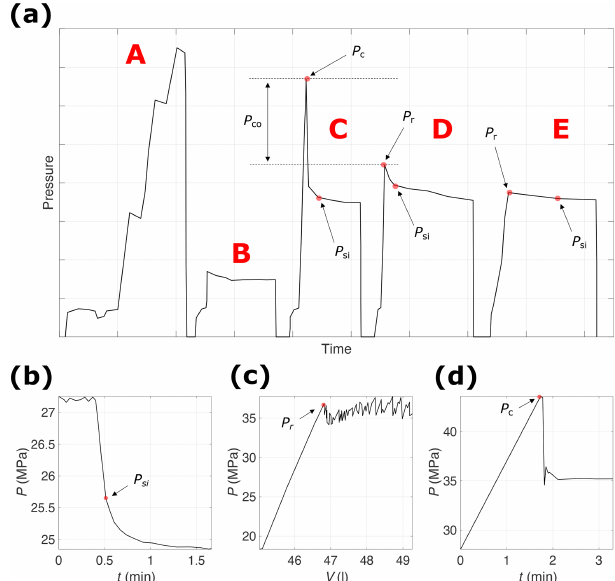
Figure 4. (a) A schematic example of a hydrofracturing test carried out in a coal mine within the Ruhr region (A – packer inflation, B – pressure pulse test, C – fracture initiation test, D – first refracturing test, and E – second refracturing test, P c – breakdown pressure at fracture initiation, P r – fracture reopening pressure, P si – shut-in pressure during fracture closure, P co – rock mass (hydrofracturing) tensile strength). An example of a typical hydrofracturing test car- ried out in an open hole section of the Natrap-1 well at true vertical depth of 1584m (MeSy, 1995d) with methodology for estimation of (b) P si , (c) P r , and (d) P c